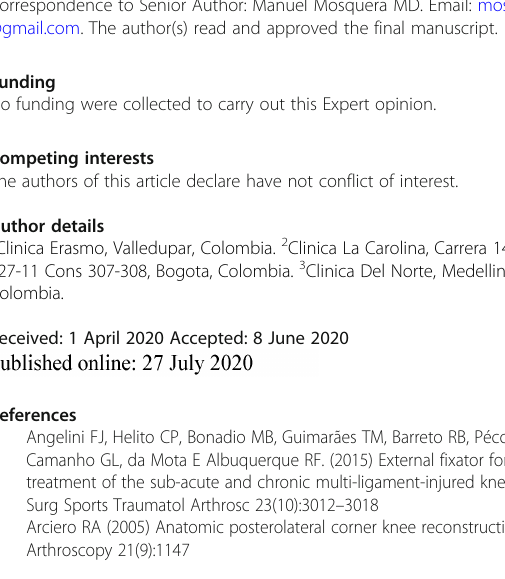
invasive arthroscopic techniques with similar results with the concept of anatomy reproduction. The import- ance of coronal and sagittal angular deformities is recog- nized as a factor of failure in chronic multi-ligament surgery and therefore osteotomies are increasingly indi- cated before ligament reconstruction, however in the setting of the acute trauma, osteotomy is not accepted for the majority of surgeons. Finally, rehabilitation pro- tocols tend to encourage early mobility and early sup- port with better functional results for patients.